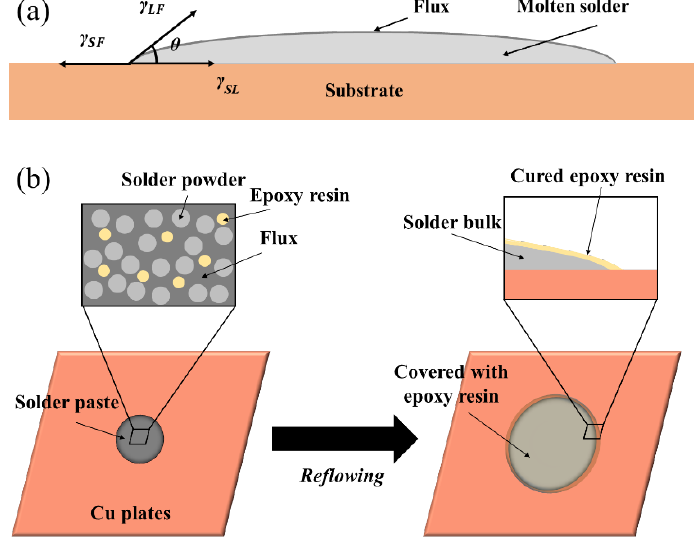
Figure 2. Schematic diagram of ( a ) wetting process of the molten solder on the substrate and ( b ) spreading process of SAC305-ER solder pastes on Cu plate.